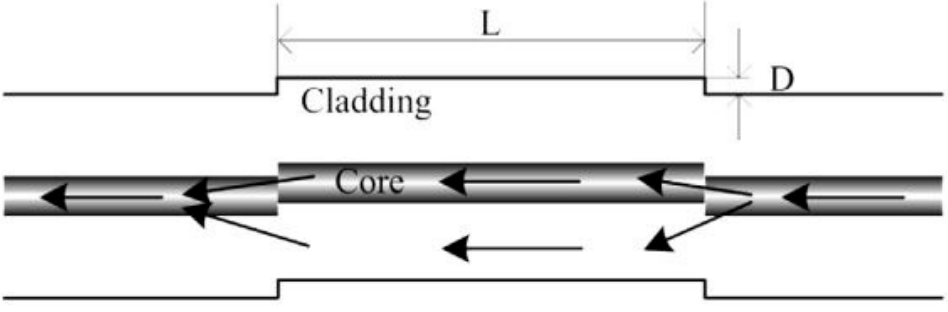
Figure 9. Schematic diagram of core-offset SMF based temperature sensor [111].